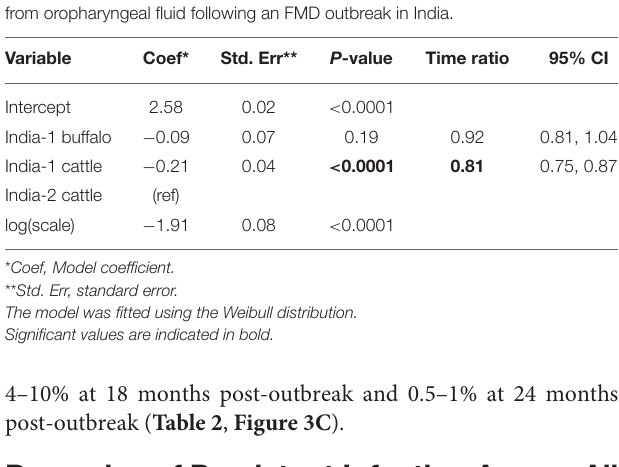
TABLE 6 | Accelerated failure time model for the duration of FMDV RNA recovery from oropharyngeal fluid following an FMD outbreak across three studies. Variable